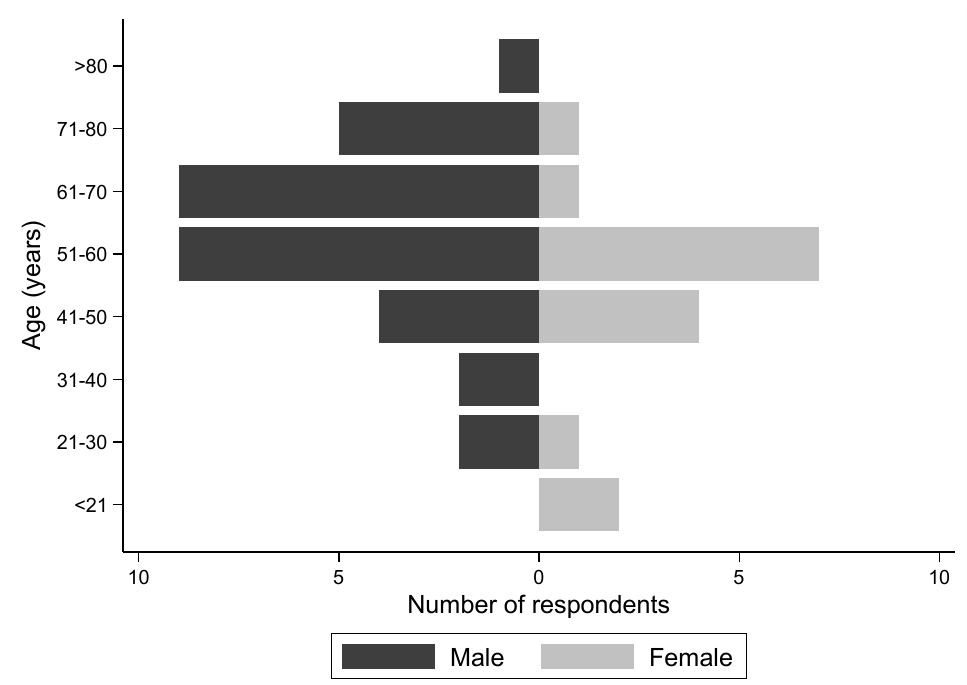
Figure 1. Population pyramid for age and gender of the 48 trainers from a cross-sectional survey of the training practices of racing greyhounds in New Zealand.